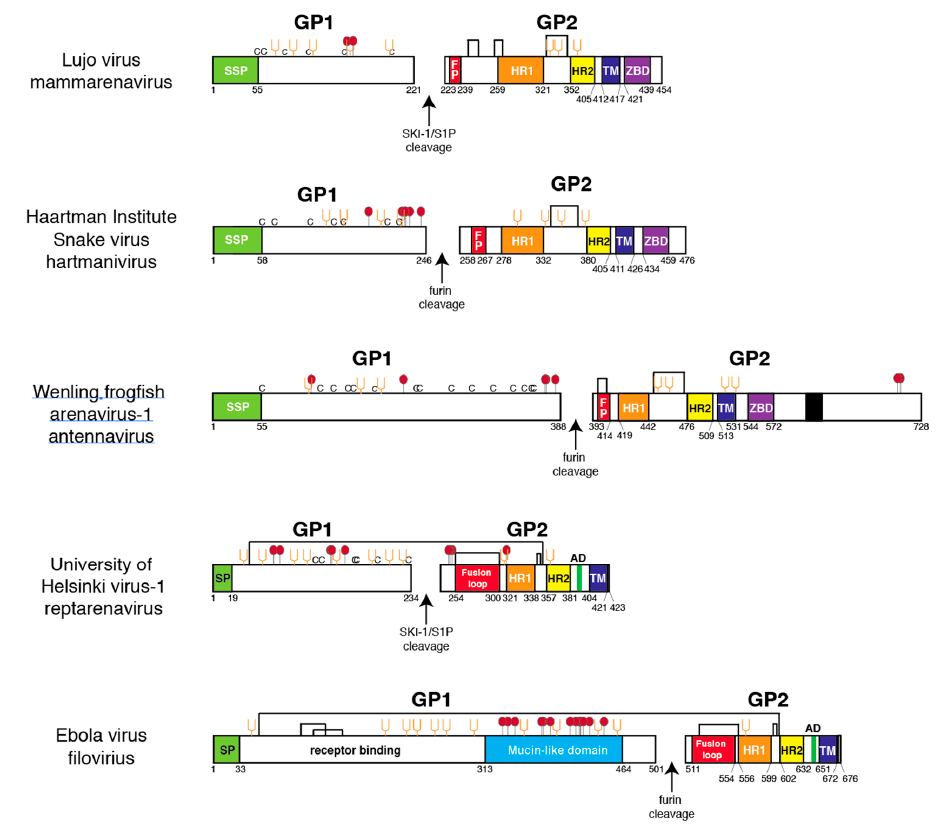
Figure 4. Linear models of glycoprotein 1 and 2 from selected members of the four arenavirus genera and a filovirus. Viruses were selected for the presence of potential O-linked glycosylation sites. Coloring and abbreviations as in Figure 1, except arrows represent cleavage sites by the indicated cellular proteases. Cysteine (C), fusion peptide (FP), zinc-binding domain (ZBD, aromatic domain (AD). Red balls: O-linked glycosylation sites. Amino acids are numbered from the N-terminus.